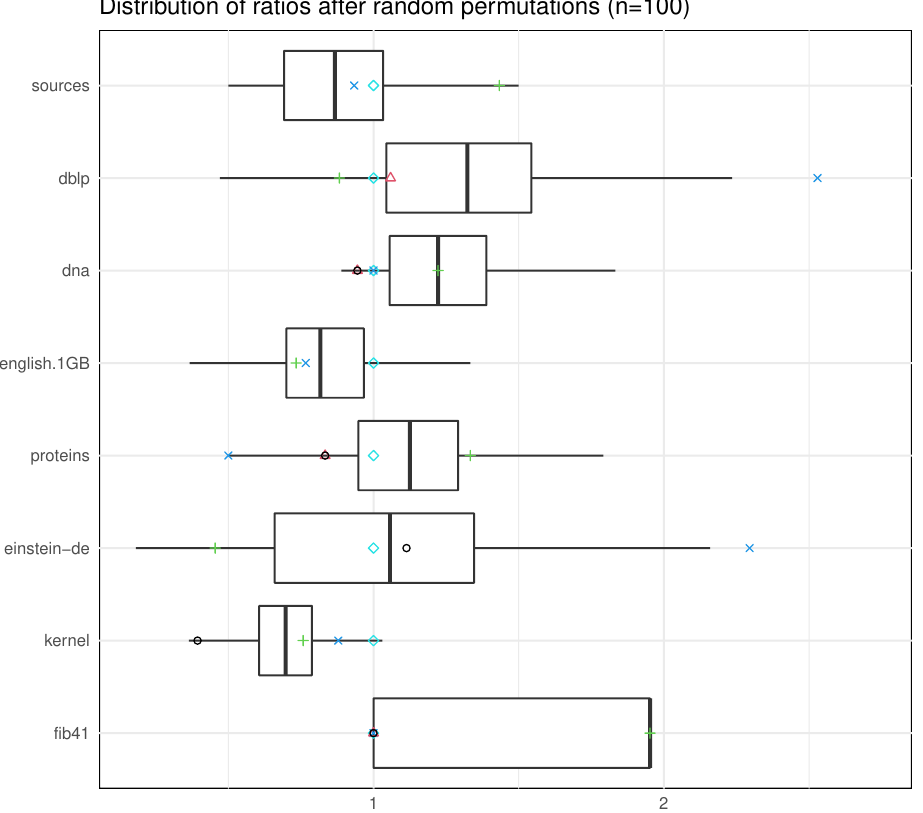
Figure 1. Number of factors for each method. Results for dataset cere were omitted because of its much larger